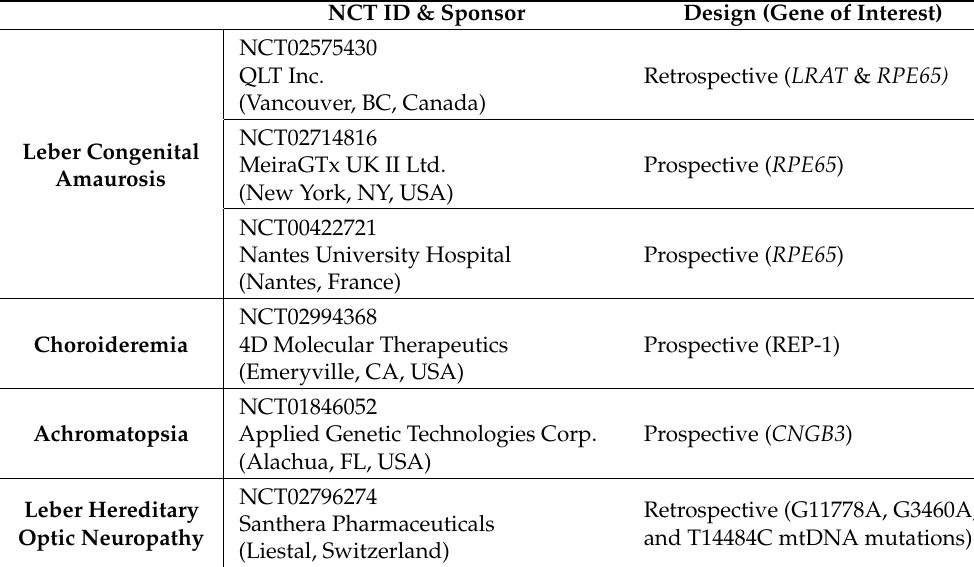
Table 2. Clinical trials for natural disease characterization of retinal